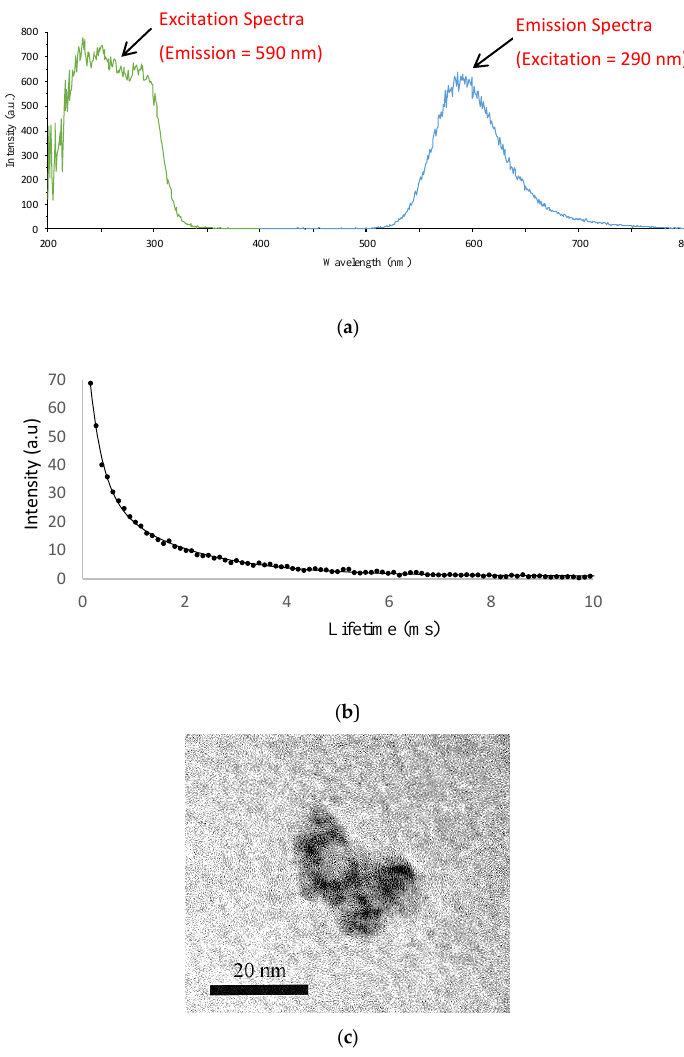
Figure 1. ( a ) Excitation and emission spectra of colloidal Mn:ZnS QDs entrapped in the sol-gel. ( b ) The phosphorescence decay curve of the QDs entrapped in the sol-gel. ( c ) TEM image of the Mn:ZnS QDs in a PBS bu ff